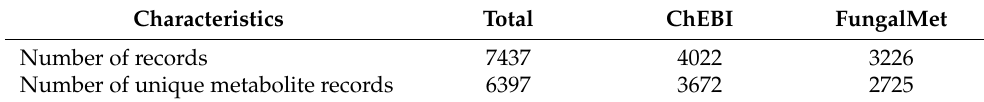
Table 4. Data from different sources in the Metabolites of Fungi database (on 26 April 2022). Characteristics Total